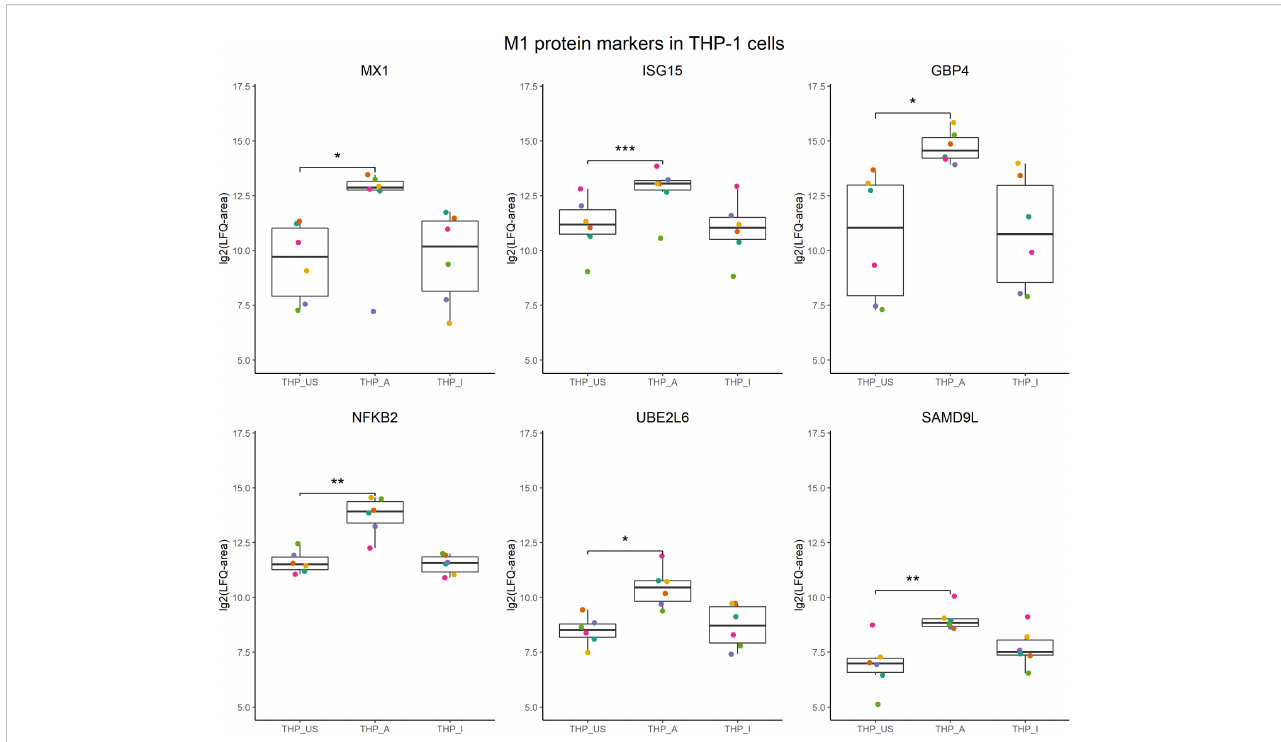
FIGURE 5 M1 protein candidates in the translatome of THP-1 cells co-cultured with 5-OP-RU-activated MAIT cells. M1 protein markers described in Huang et al, 2018 with an M1/M0 ratio ≥ 4 were compared with the translatome of THP-1 cells after 5-OP-RU stimulation with MAIT cells. Proteins shown were de fi ned as M1 markers, and differentially upregulated (p<0.05, log 2 (FC)>1, except low-con fi dent proteins) in the translatome. p* ≤ 0.05; p** ≤ 0.01; p*** ≤